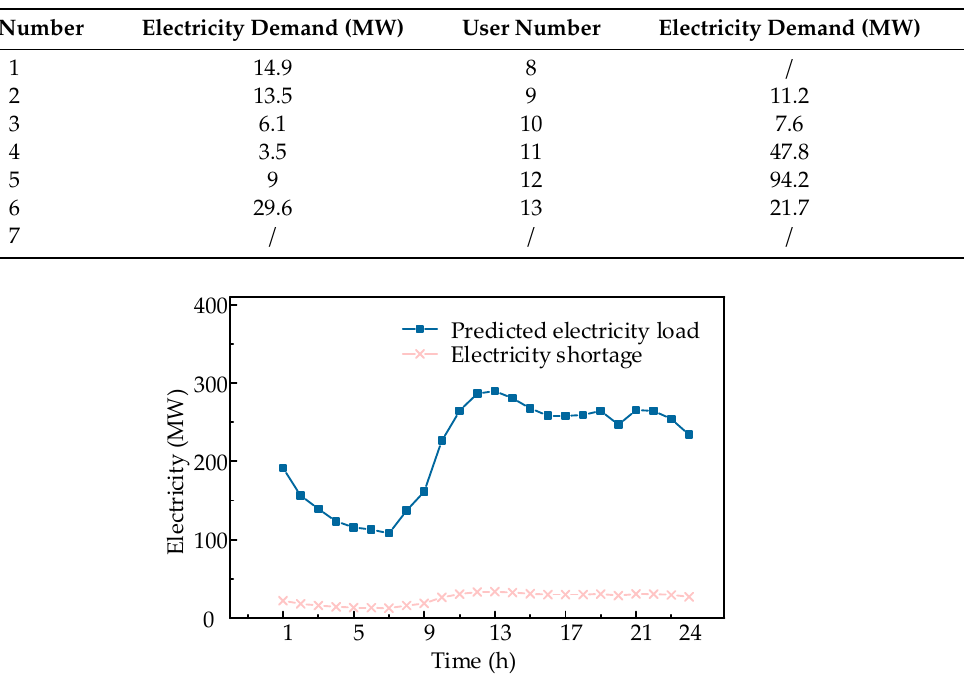
Figure A1. The topology of the 14-node receiving-end electricity network. Table A1. The electricity load of each node at t = 18. Table A1. The electricity load of each node at t = 18.